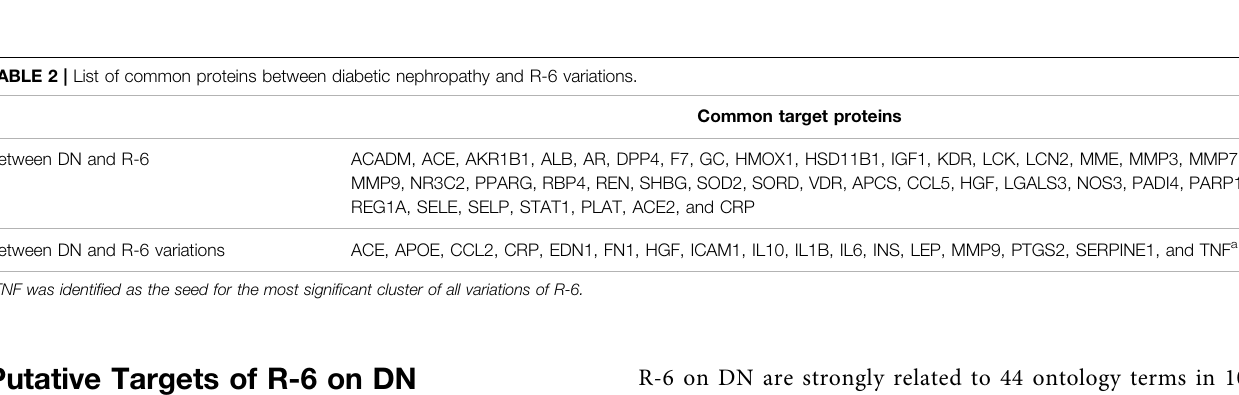
FIGURE 3 | Network of R-6 putative targets and clusters of DN – R-6 interaction network. Forty DN-related genes were overlapped with and R-6; (A) 449 potential gene targets of R-6; (B) putative targets of R-6 on diabetic DN; (C – O) Major clusters of putative targets of R-6 on DN